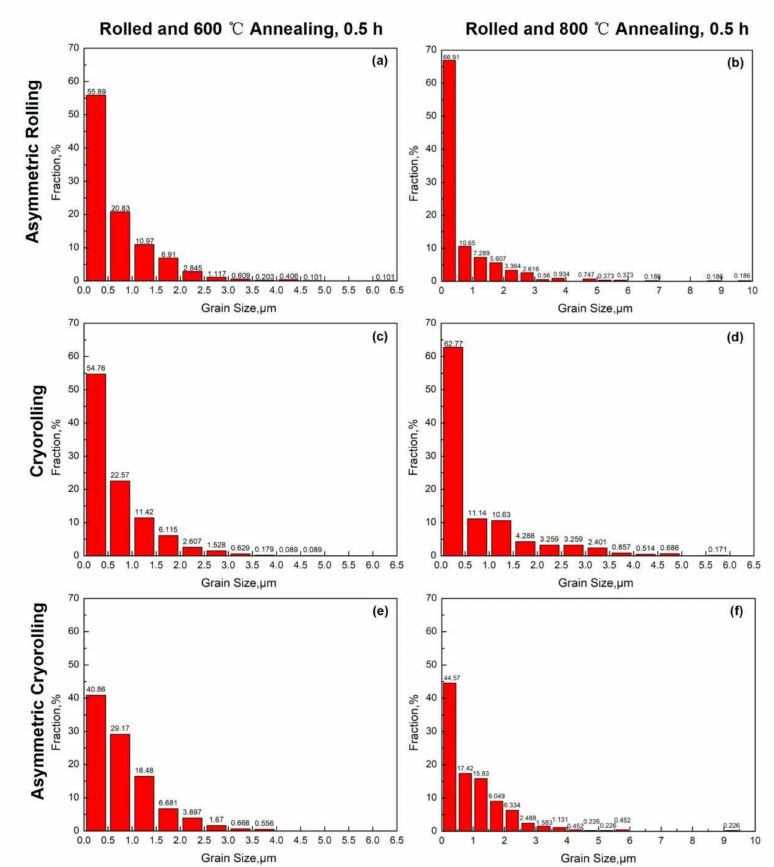
Figure 2. Grain size distribution of ( a ) asymmetrically rolled MEA CrCoNi with annealing at 600 ◦ C, ( b ) asymmetrically rolled MEA CrCoNi with annealing at 800 ◦ C, ( c ) cryorolled MEA CrCoNi with annealing at 600 ◦ C, ( d ) cryorolled MEA CrCoNi with annealing at 800 ◦ C, ( e ) asymmetric cryorolled MEA CrCoNi with annealing at 600 ◦ C, and ( f ) asymmetric cryorolled MEA CrCoNi with annealing at 800 ◦